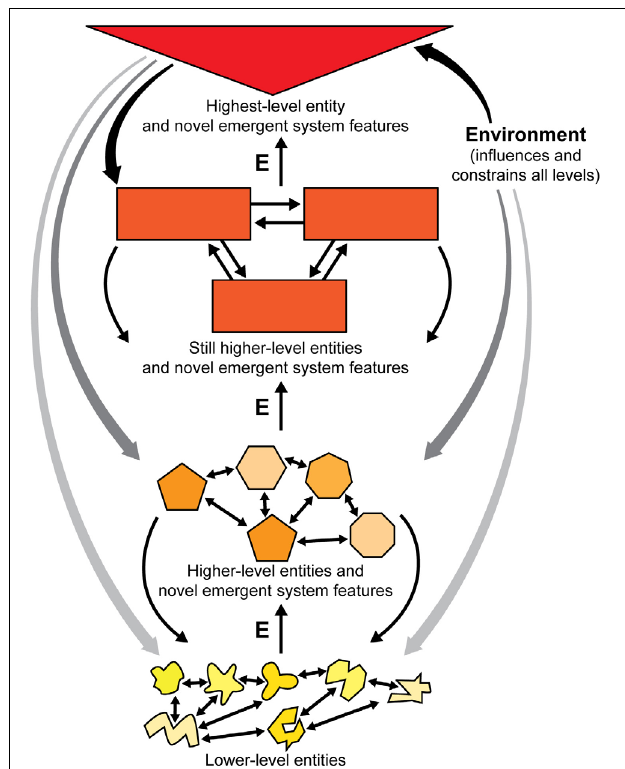
FIGURE 1 | Emergence through a hierarchy in a complex system. Lower levels combine to make the higher levels. New features emerge (E) in the system as more levels are added. The many connections are reciprocal, as shown by the back-and-forth arrows, both between and within levels. Also see Table 1 . Figure © Mount Sinai School of